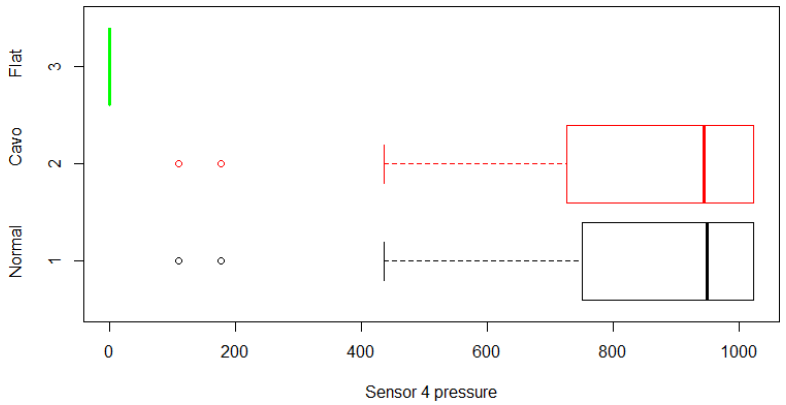
Figure 6. Normal distribution analysis of Sensor